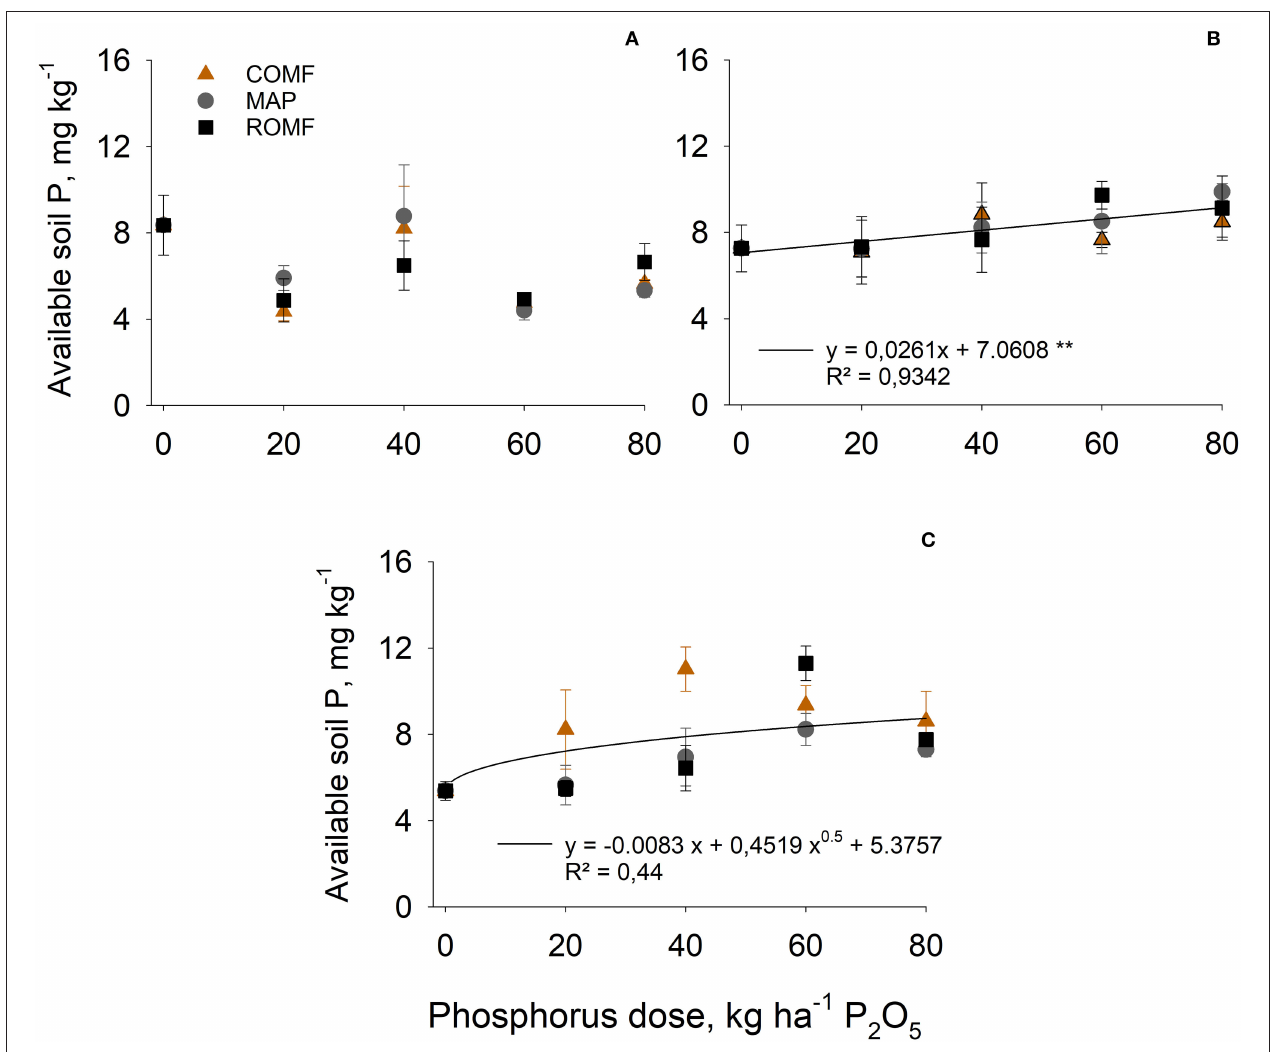
FIGURE 5 | Available soil P (Mehlich-1) after treatment with different organomineral and MAPfertilizers and doses in the crop seasons of 2010/2011 (A) , 2012/2013 (B) , and 2013/2014 (C) . COMF, composted organomineral fertilizer; MAP, monoammonium phosphate; ROMF, raw poultry litter organomineral fertilizer.